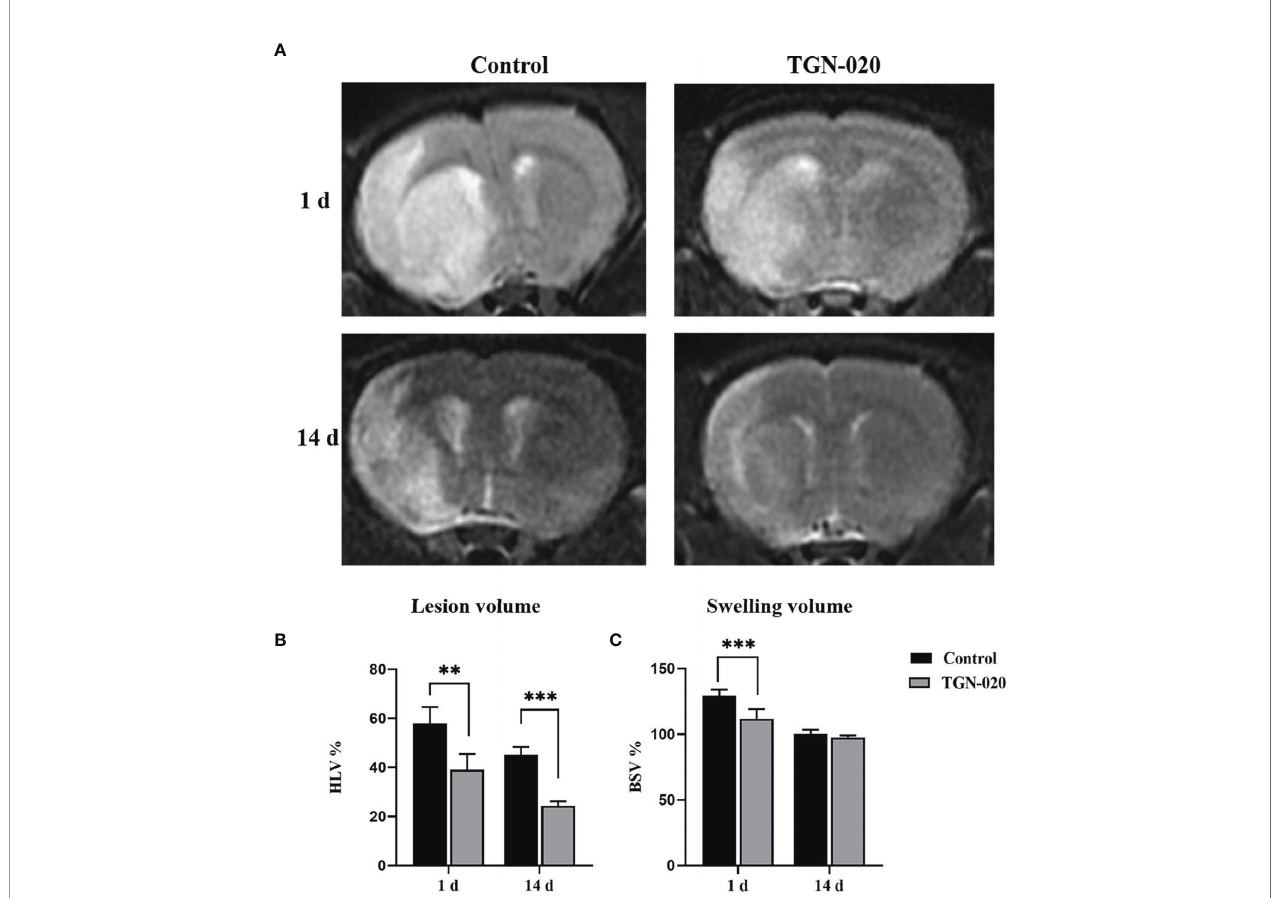
FIGURE 1 | Comparison of ischemic lesion volumes and brain swelling volumes between groups. (A) Representative T2-WI images of rats in the TGN-020-treated and control groups at 1 day and 14 days post-stroke. (B) The ischemic Lesion volumes of each group at 1 day and 14 days post-stroke. (C) The brain swelling volumes of each group at 1 day and 14 days post-stroke. ** P < 0.01, *** P <